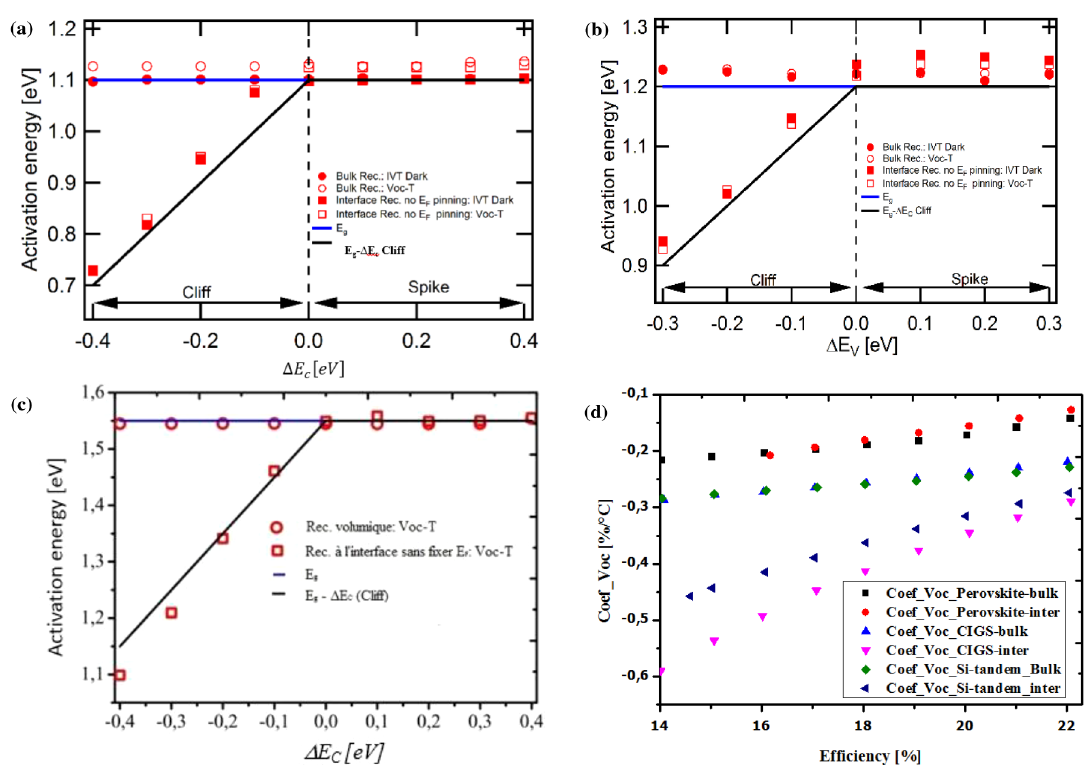
Fig. 4. The summary of the results of the energy of the two methods for activating the tandem amorphous/microcrystalline (a), CIGS (b) and Perovskite (c) and (d) variation of the open circuit voltage temperature coef fi cient as a function of ef fi ciency.